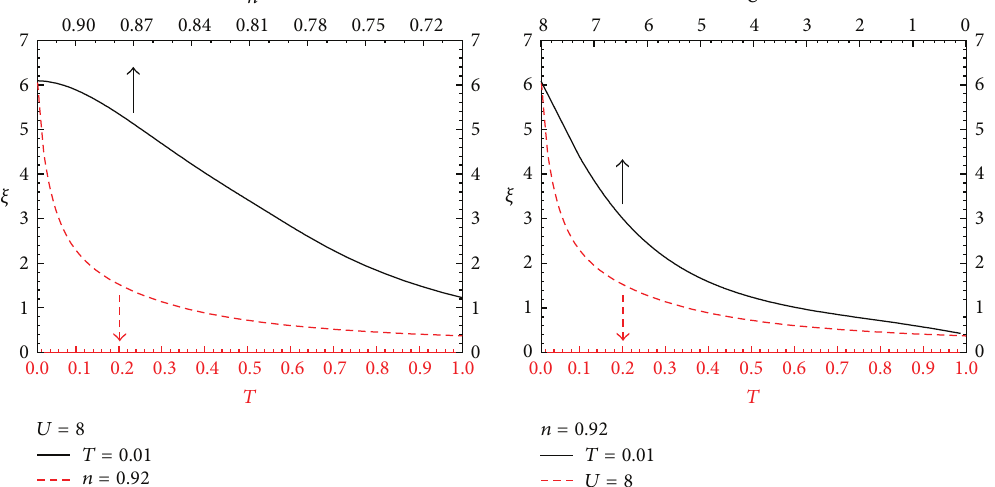
Figure 12: (Color online) The antiferromagnetic correlation length 𝜉 as a function of filling 𝑛 , temperature 𝑇 , and on-site Coulomb repulsion 𝑈 in the ranges 0.7 < 𝑛 < 0.92 , 0.01 < 𝑇 < 1 , and 0.1 < 𝑈 < 8 .